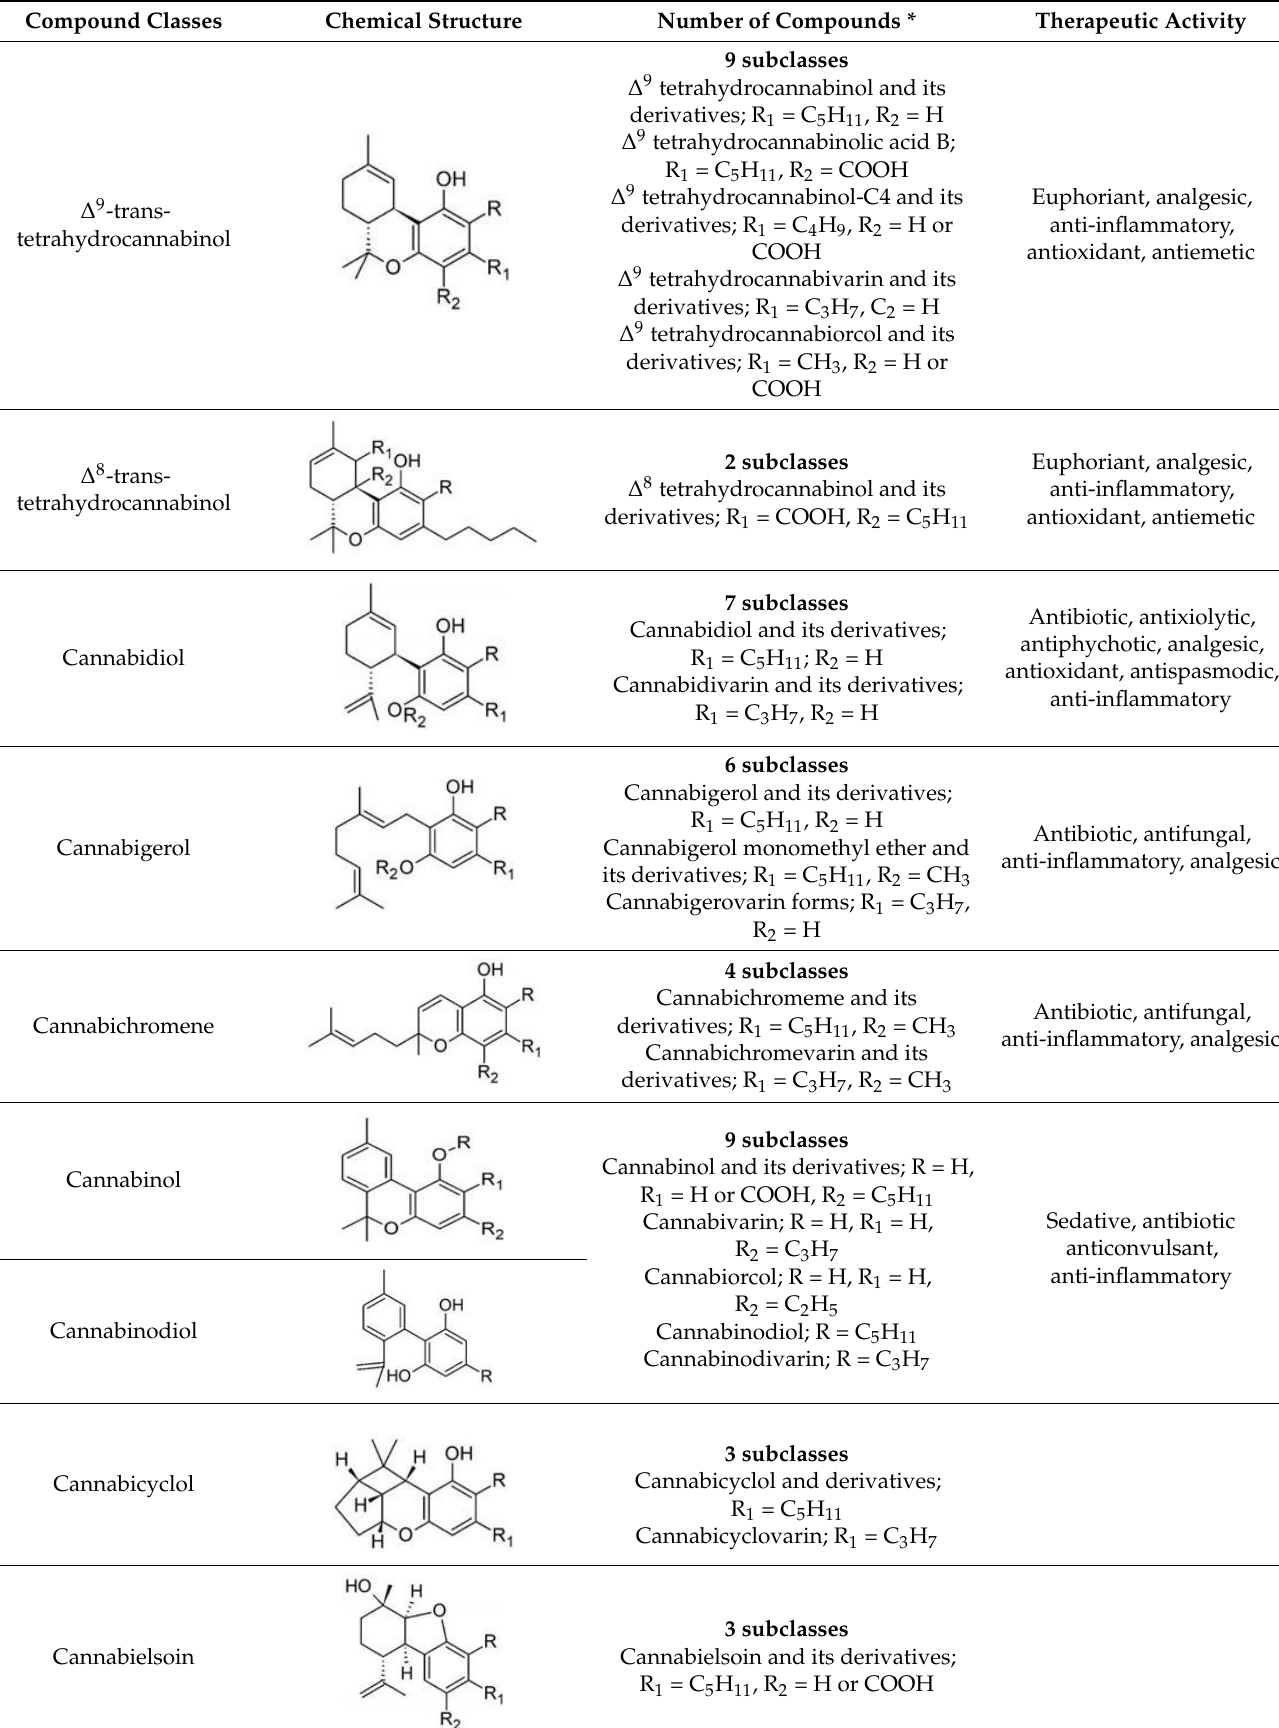
Table 1. Phytocannabinoid classes.